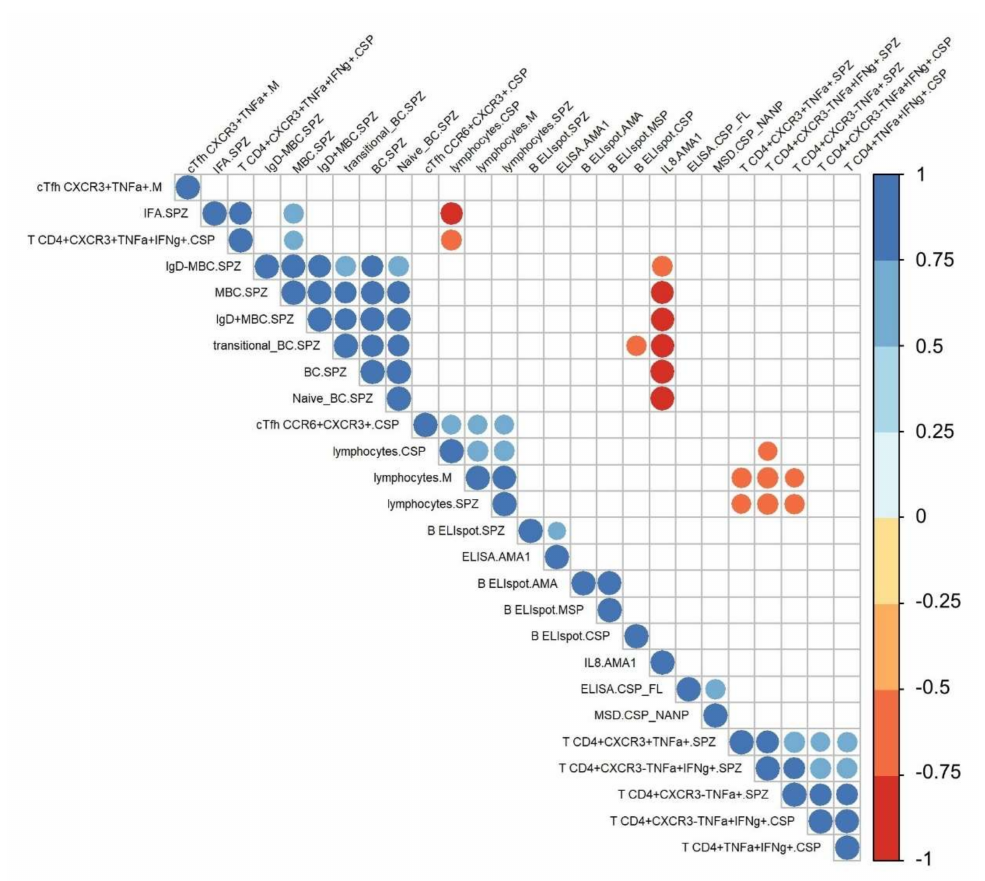
Figure 2. Immune signatures induced by IMRAS vaccination. The immunological landscape was established by integrating the results of all immune assays performed on longitudinal samples from IMRAS-vaccinated subjects. Twenty-six immune measures were significantly ( p < 0.05, q < 0.05) associated with IMRAS immunization at T1. The correlation matrix of these measures shows only significant correlations (Spearman, (cid:36) > 0.4, p < 0,05). The color and size of the dots (scale next to graph) indicate the degree of correlation between the different parameters (small to large indicating low to high